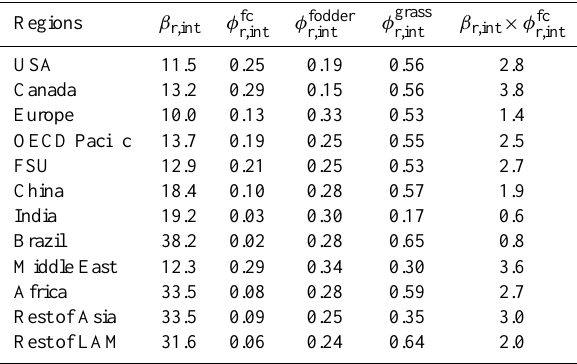
Table 5. Feed conversion factor of intensive ruminants β r,int (kcal of feed/kcal of ruminant product). Share of food crops φ fc φ fodder and grass φ grass in feed. Calories of food crop needed to r,int r,int produce one calorie of intensive ruminant meat and milk β r,int × φ fc . From Bouwman et al. (2005) and modified as explained in r,int Sect. 5.4